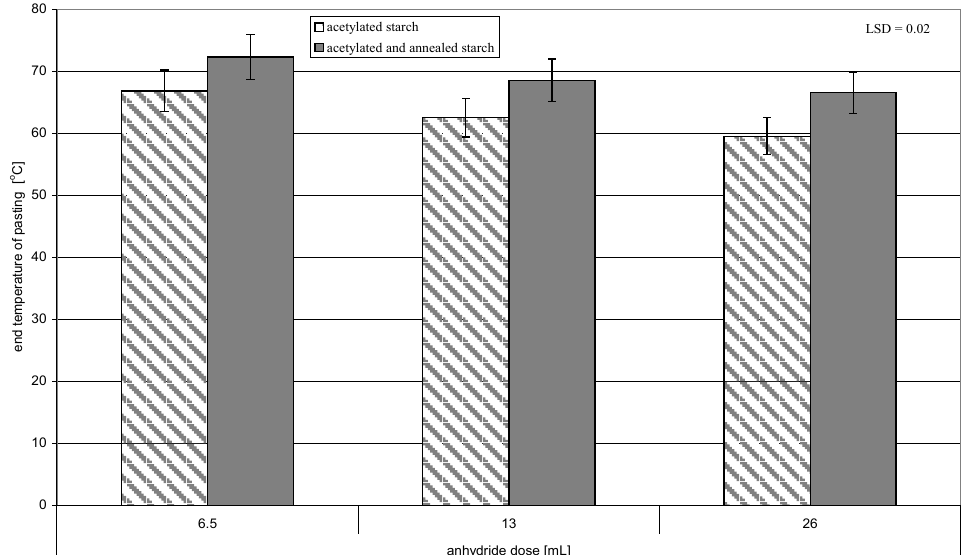
Figure 3. End temperature of pasting of preparations of acetylated starch and of acetylated and annealed starch.